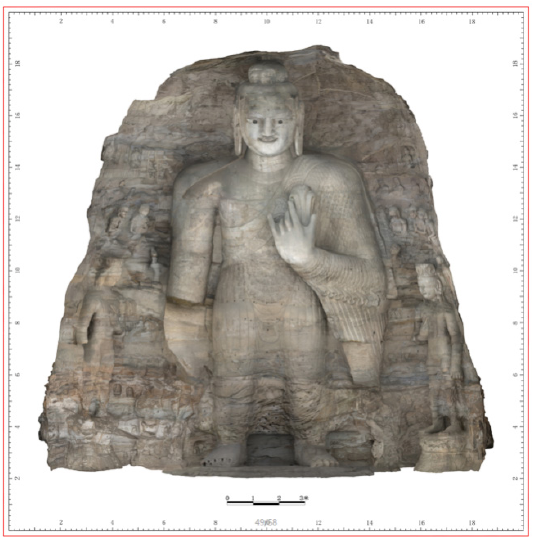
Figure 8. The main Buddhist Orthophoto of the 18th cave of the Yungang Grottoes.